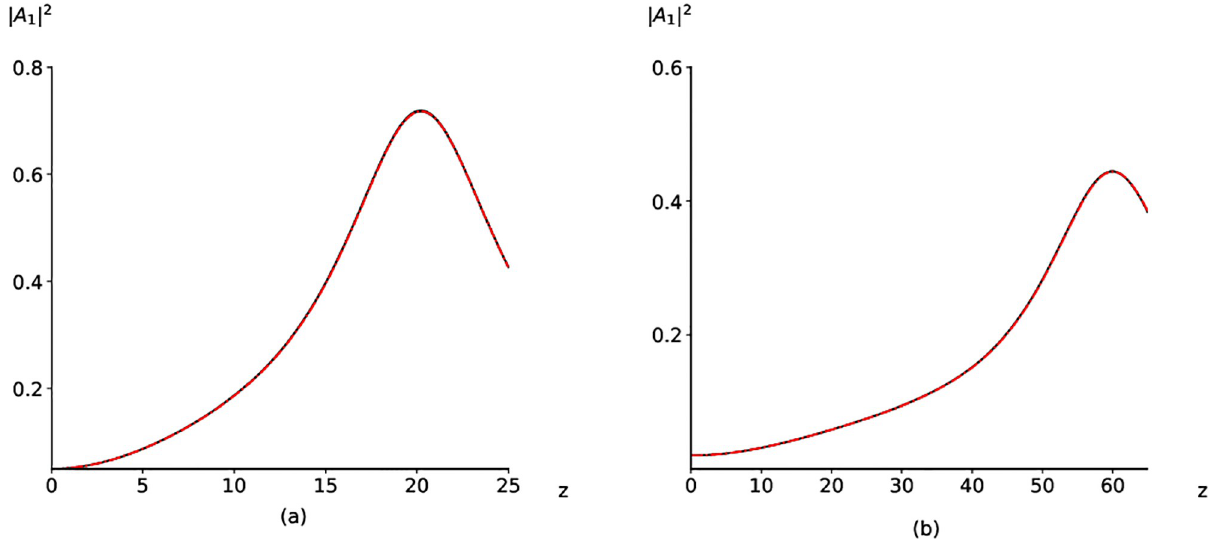
Fig 6. Computer simulation results obtained by using the original problem (black solid lines) and the modified problem (red dashed-dotted lines) computed for the parameters γ 1 = 4, Δ 21 k = 80, | A 20 | 2 = 0, φ 0 = 0 and ( γ 2 , | A 10 | 2 ) = (2, 0.05) (a), 0 : 02 ; 4